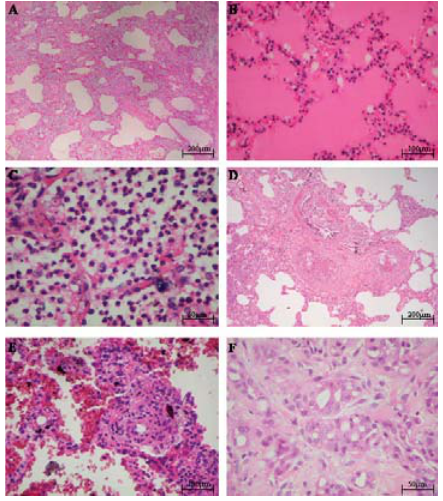
Figure 1 - Secondary interstitial pneumonia / diffuse alveolar damage in immunocompromised patients: (A) diffuse alveolar damage, showing a homogeneous distribution of the inflammatory process and hyaline membranes; (B) cardiogenic pulmonary edema, showing the proteinaceous intra-alveolar transudate; (C) diffuse alveolar damage in patients who developed concomitant bronchopneumonia, showing the numerous neutrophils inside of the alveolar space; (D) pulmonary thromboembolism, showing the significant vascular occlusion; (E) pulmonary hemorrhage, showing alveolar spaces containing red cells; and (F) a case with primary lung cancer. Hematoxylin & eosin X 200 (panels A, D), X 100 (panels B, E), and X 50 (panels C,